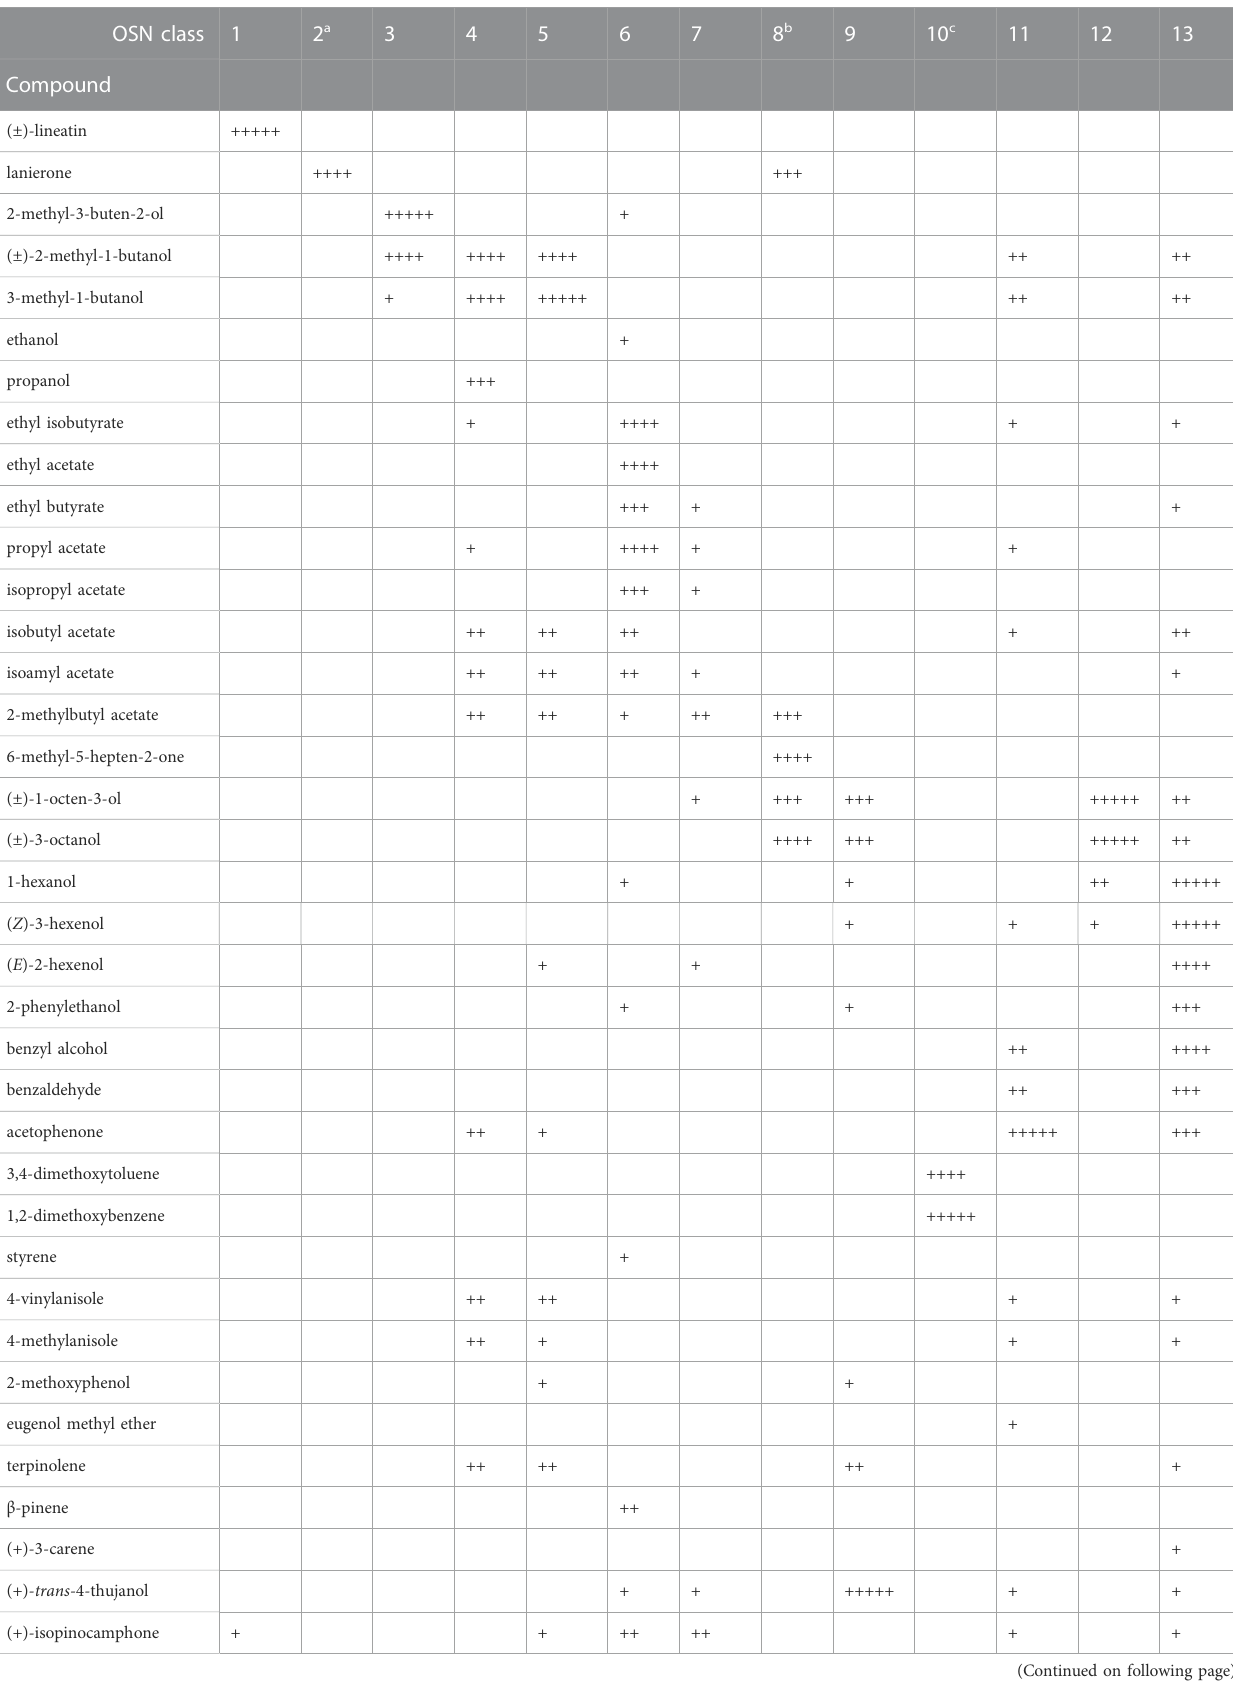
TABLE 1 Response pro fi le of 13 olfactory sensory neuron (OSN) classes responding strongly ( ≥ 80 Hz) to one or several compounds at the 10 μ g stimulus